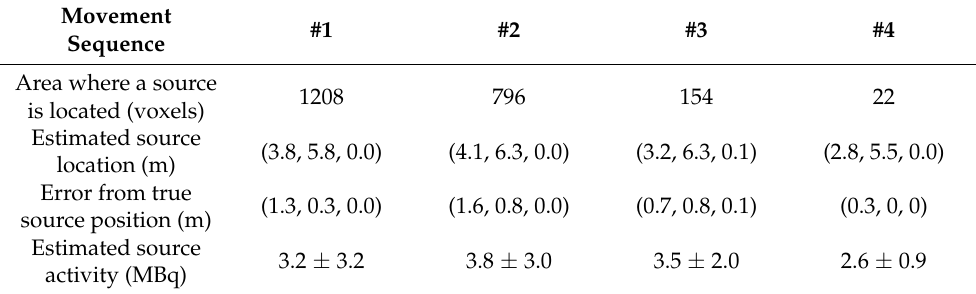
Table 5. Summary of the estimated source intensities and locations obtained by Path II in the inte- grated simulation model. Movement Sequence